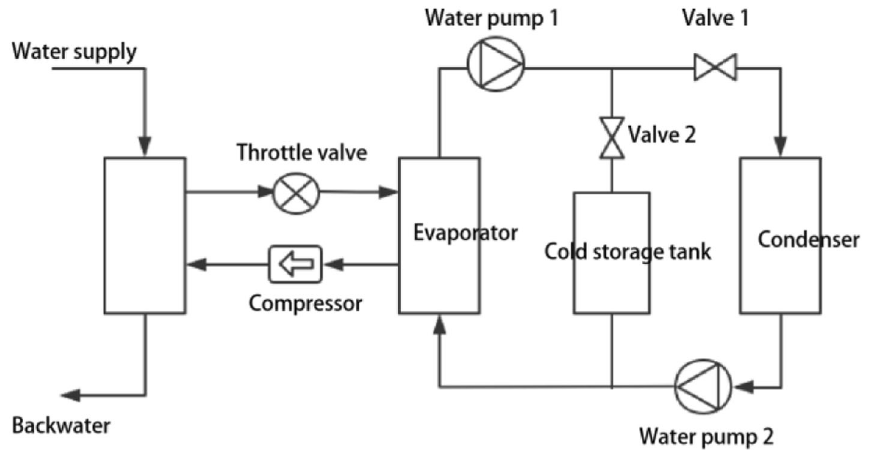
Fig. 11 The schematic diagram of GSHP coupled with ice storage system